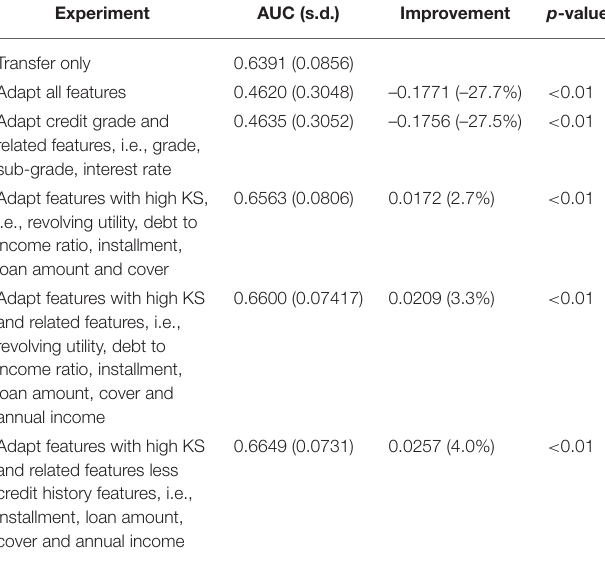
TABLE 6 | Adapted model vs. transferred model in CD to MD